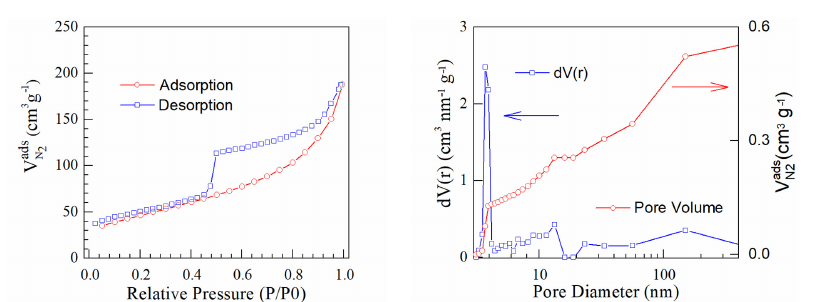
Figure 5. Sample PtrGO1.